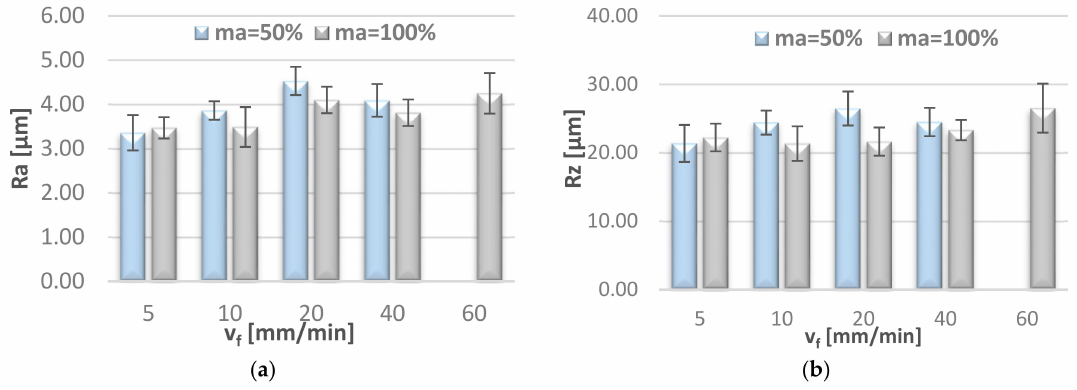
Figure 10. Effect of jet feed velocity v f on surface roughness parameters: ( a ) Ra and ( b ) Rz, measured in the middle of specimen